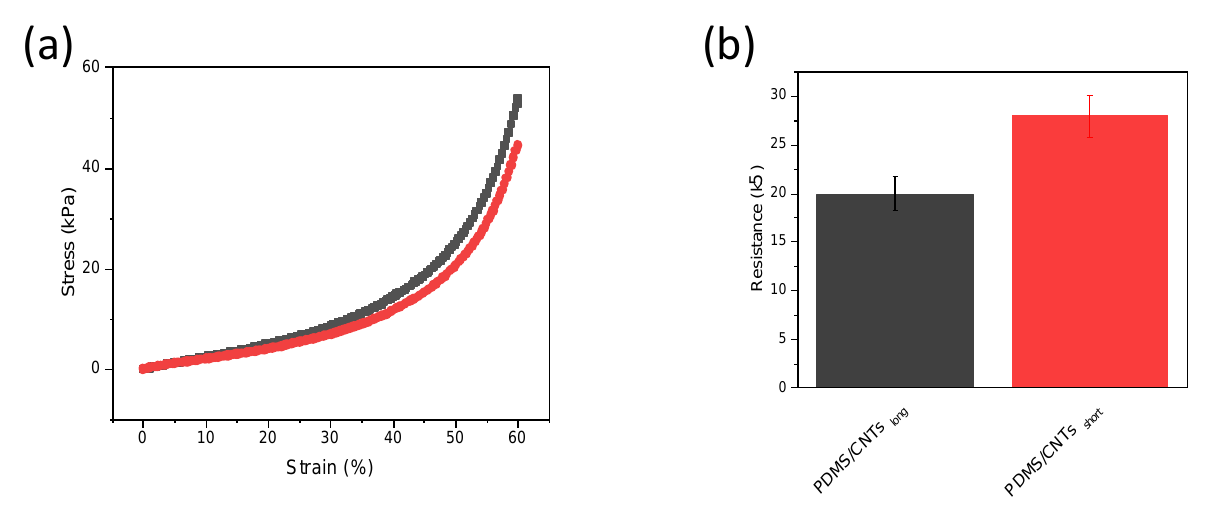
Figure 4. ( a ) Compressive stress–strain curves at 60% strain of PDMS/CNTs long (gray curve) and PDMS/CNTs short (red curve), ( b ) recorded resistance of PDMS/CNTs long ; PDMS/CNTs short (error bars are calculated on n = 3).